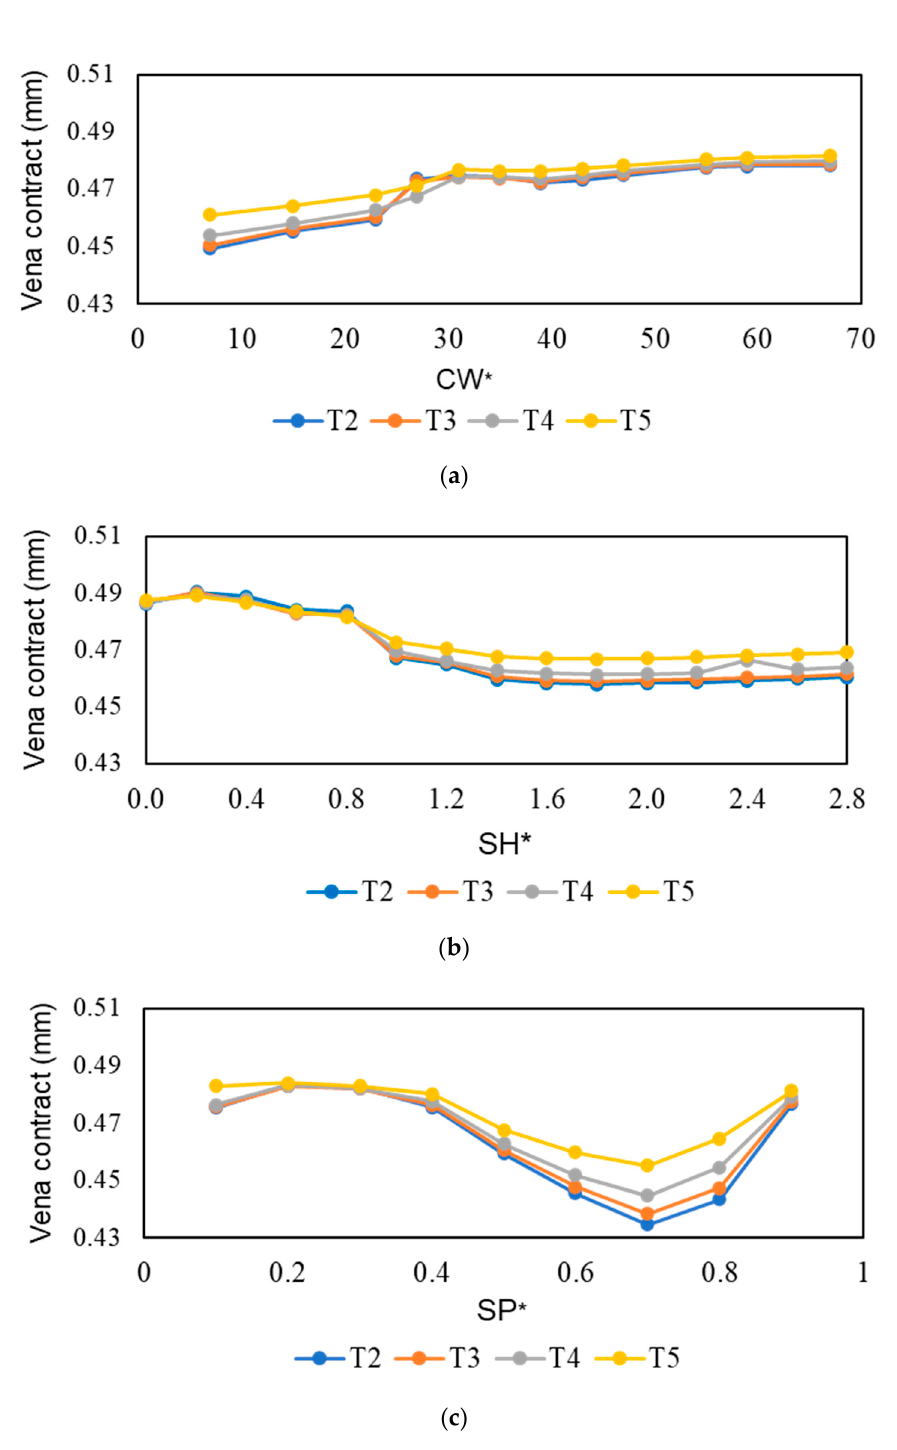
Figure 11. Vena ‐ contracta changes due to geometrical parameters. ( a ) CW*. ( b ) SH*. ( c ) SP*. Figure 12 shows the normalized axial velocity in the radial direction in the second- tooth structure and Cn. The solid lines indicate the shapes with large discharge coefficients, and the dotted lines indicate those with small discharge coefficients. The shapes with large discharge coefficients exhibited a steep increase in the axial speed at the clearance inlet, and those with small discharge coefficients exhibited a relatively gentle axial